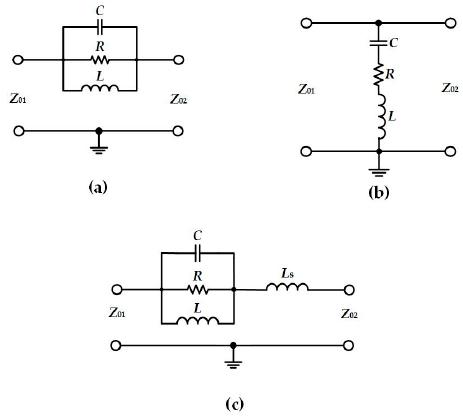
Figure 2. Schematics of the ( a ) original parallel NGD (negative group delay) circuit, ( b ) original series NGD circuit, and ( c ) modified NGD circuit.